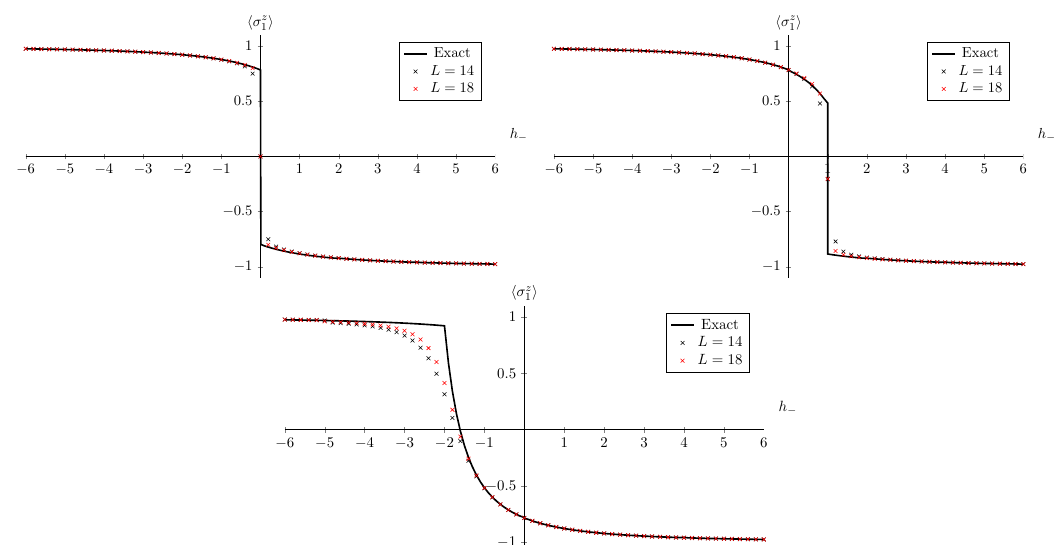
Figure 11: Comparison of the exact result for the magnetization at the boundary (5.14) in the thermodynamic limit, against numerical exact diagonalization results. Above left : h + = 0. Above right : h + = 1. Below : h + = − 3.5. For a chain at ∆ = 3 and lengths 14 and 18. Note that the discontinuity of the boundary magnetization appears only in the thermodynamic limit, due to the closing of the gap between the ground state and the first excited state at h − = h + in this limit, see Fig.